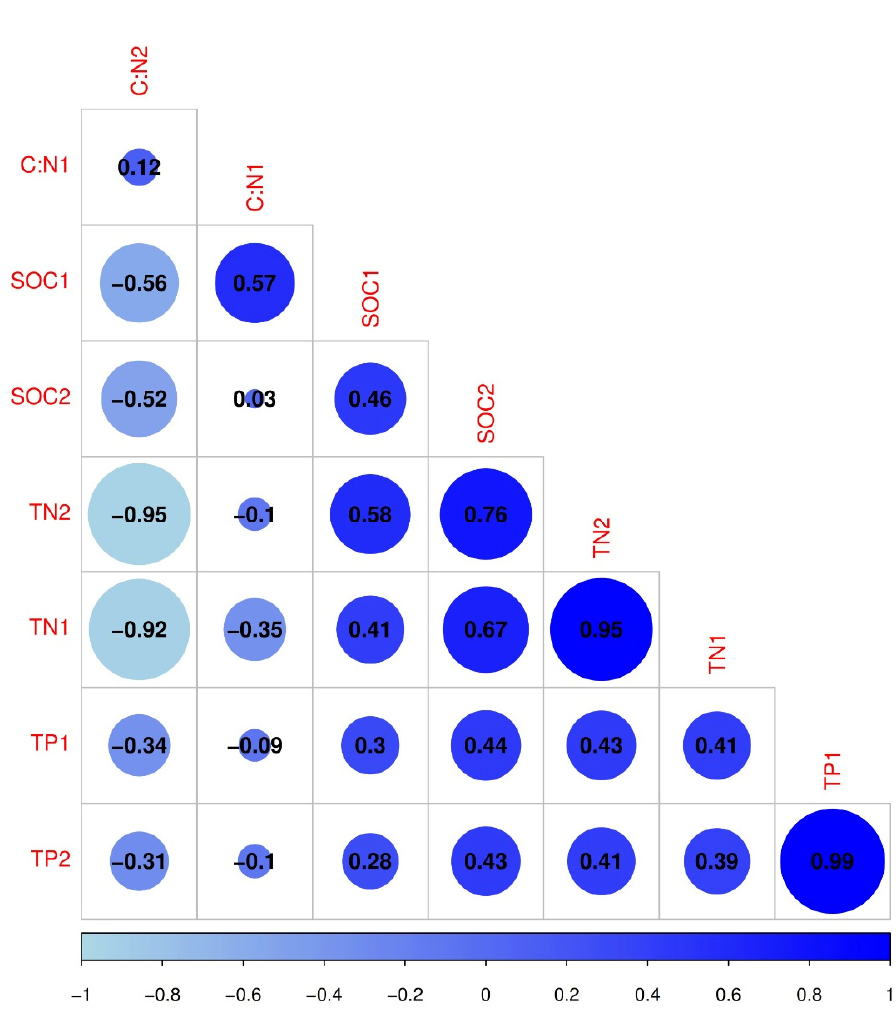
Figure 3. Correlation analysis between the analyzed parameters during the two years of